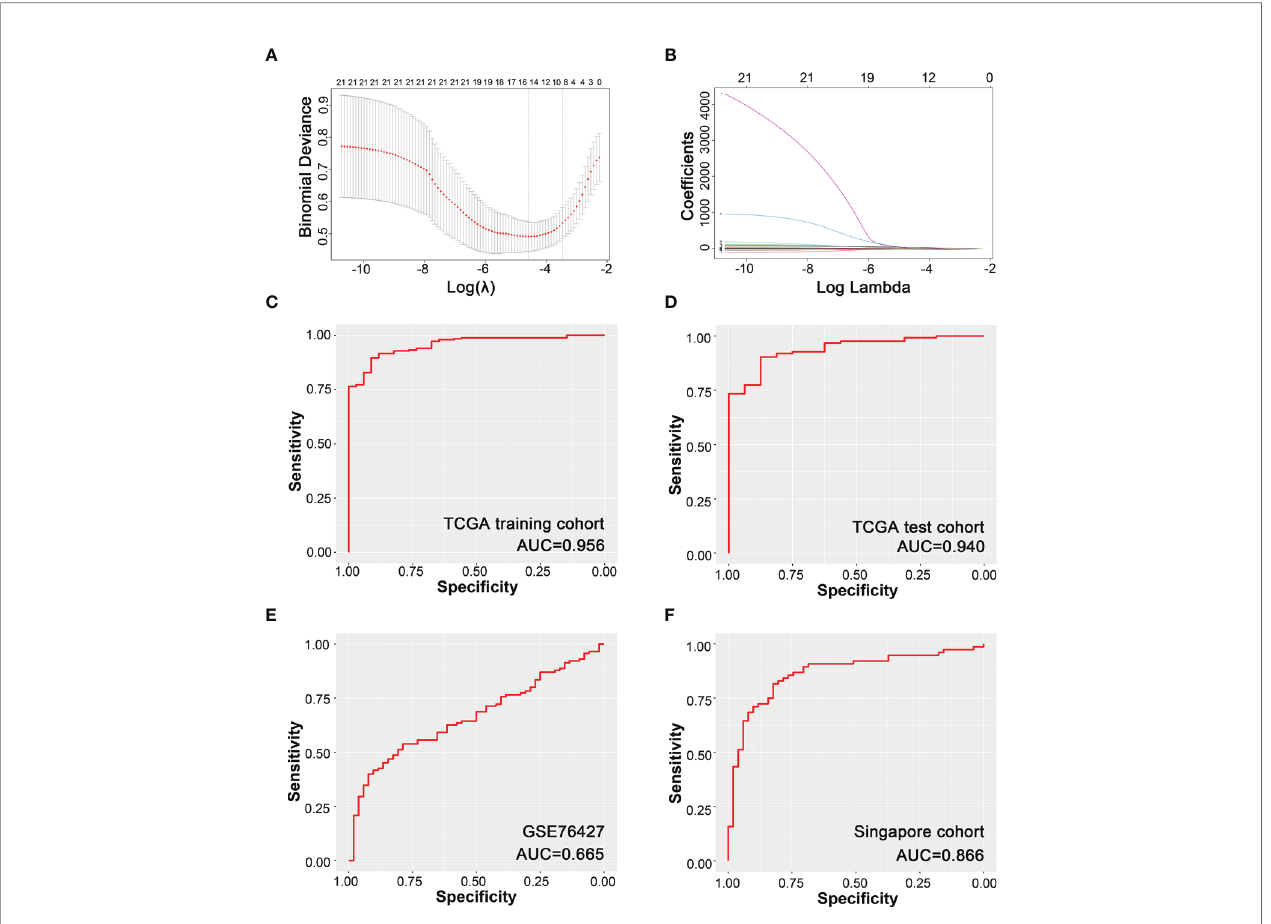
FIGURE 2 | Diagnostic model of HCC based on immune cells in fi ltration. (A) Binominal deviance for different numbers of variables simulated by LASSO-logistic regression model. (B) Coef fi cients of different numbers of variables in LASSO regression model. (C) Modeling based on TCGA training cohort. (D) Internal test based on TCGA test cohort. (E) External validation based on GSE76427. (F) External validation based on Singapore